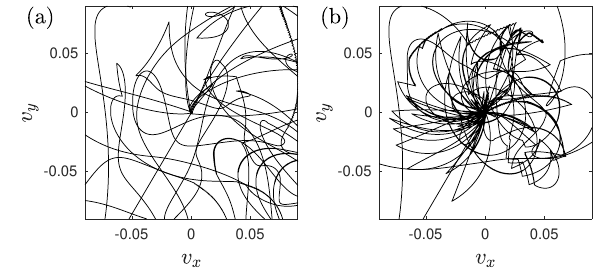
Figure 5. Contact velocity of the spheroid on the plane with m red , tang with a a mostly smooth velocity variation in (a) and with m red leading to abundant erratic changes in (b).